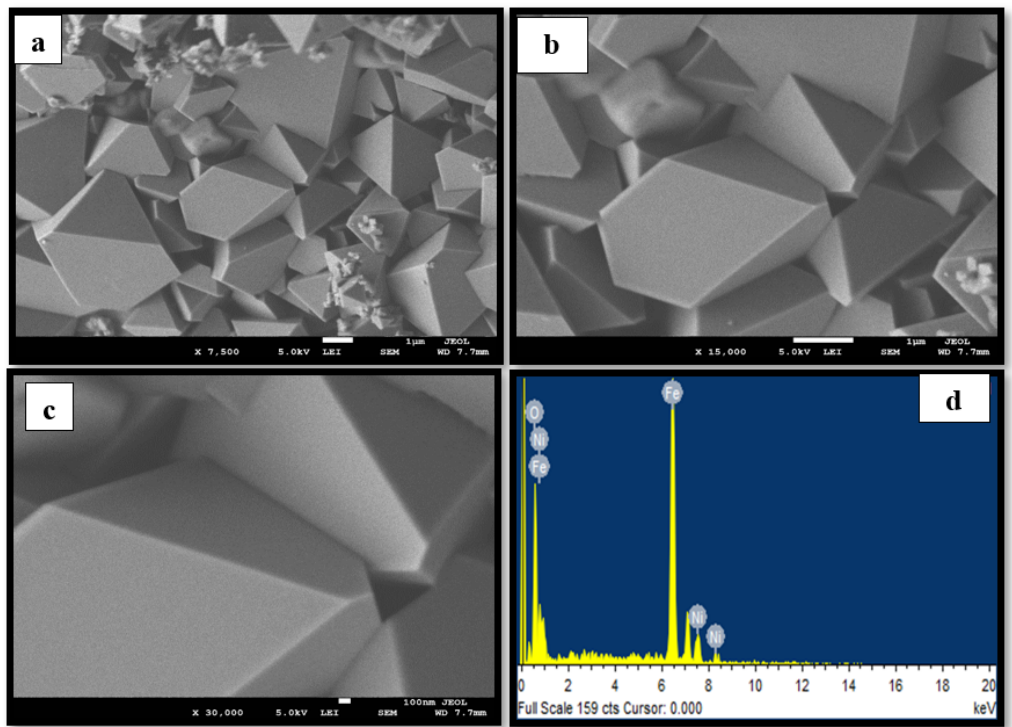
Figure 2. Representative ( a – c ) FESEM images at different magnifications and ( d ) EDS spectrum of the synthesized spinel (2:1) NiFe 2 O 4